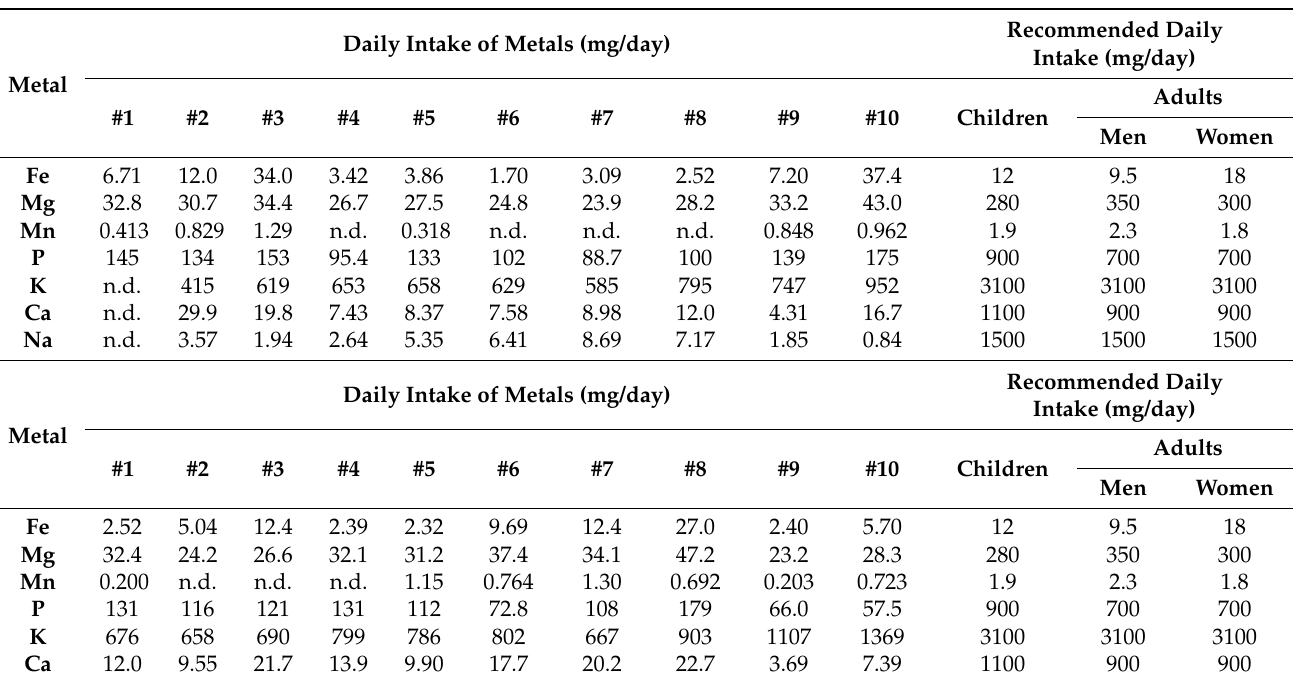
Table 4. Daily intake of metals in samples of Lactarius mushrooms analyzed and recommended daily intake.